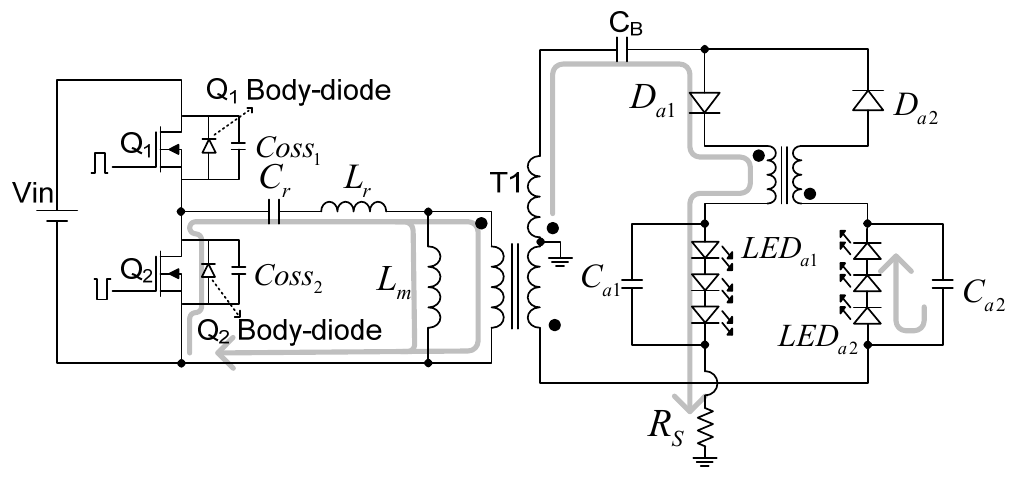
Figure 9. Circuit diagram during Mode 4.